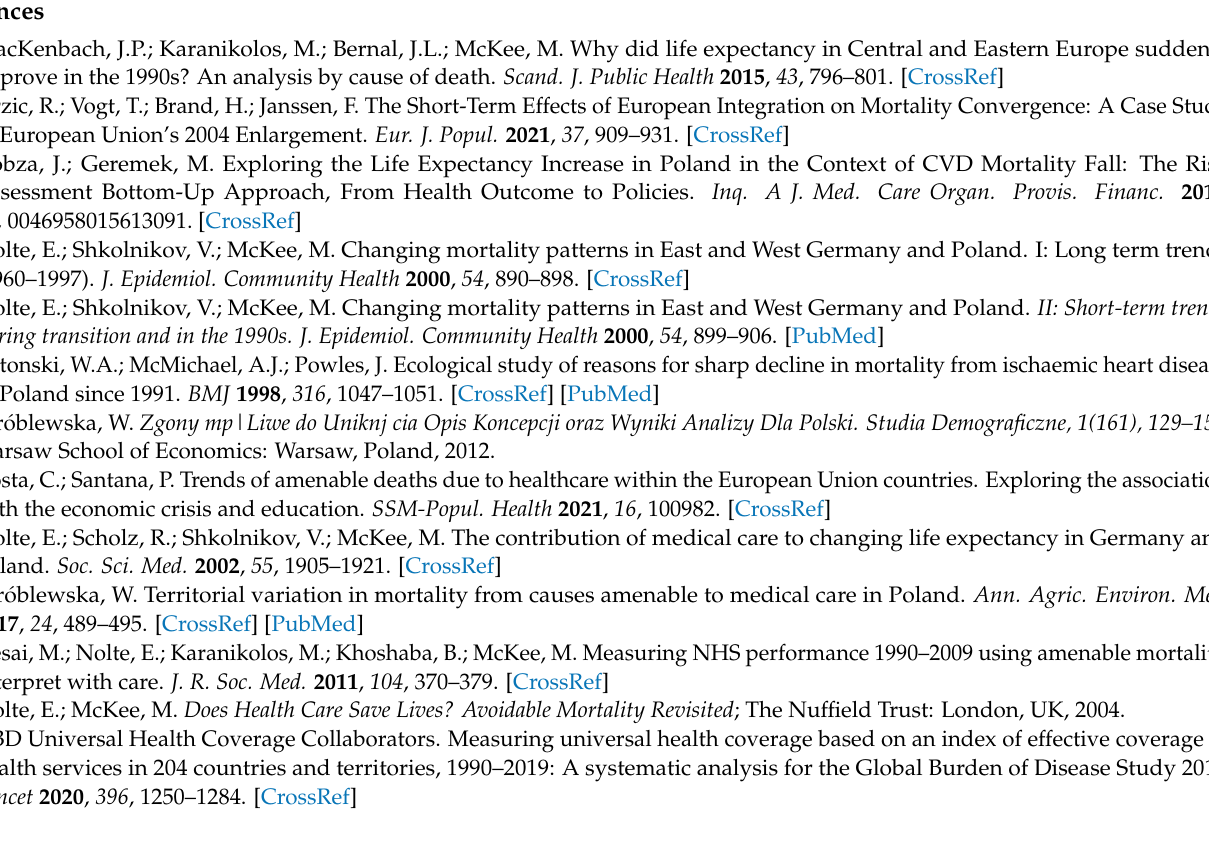
Table S2: Change in amenable mortality by major cause of death,